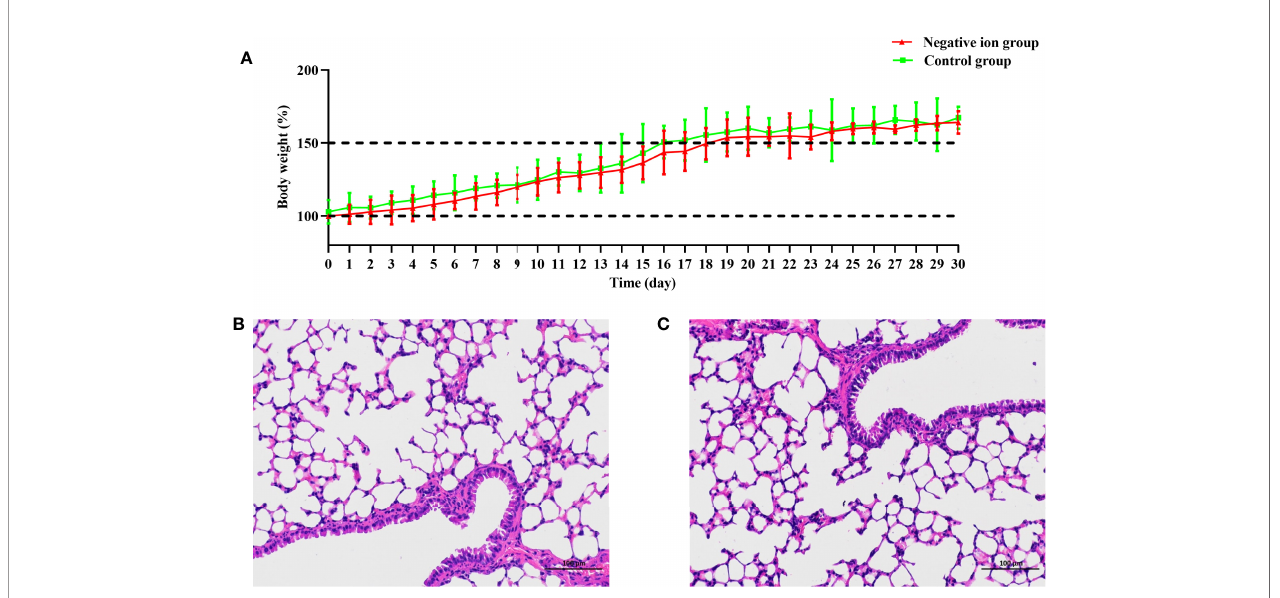
FIGURE 7 | Body weight change and lung pathological observation of mice exposed to negative ions for 30 days. Ten mice were exposed to negative ions for 30 days, and the other 10 mice were used as control. The air ionizer is mounted on the inner wall of the cage. The body weight of mice was monitored daily (A) . Lungs of the control mice (B) and ion-exposed mice (C) were collected on day 30 and were fi xed with formalin, embedded in paraf fi n, and stained with hematoxylin and eosin.